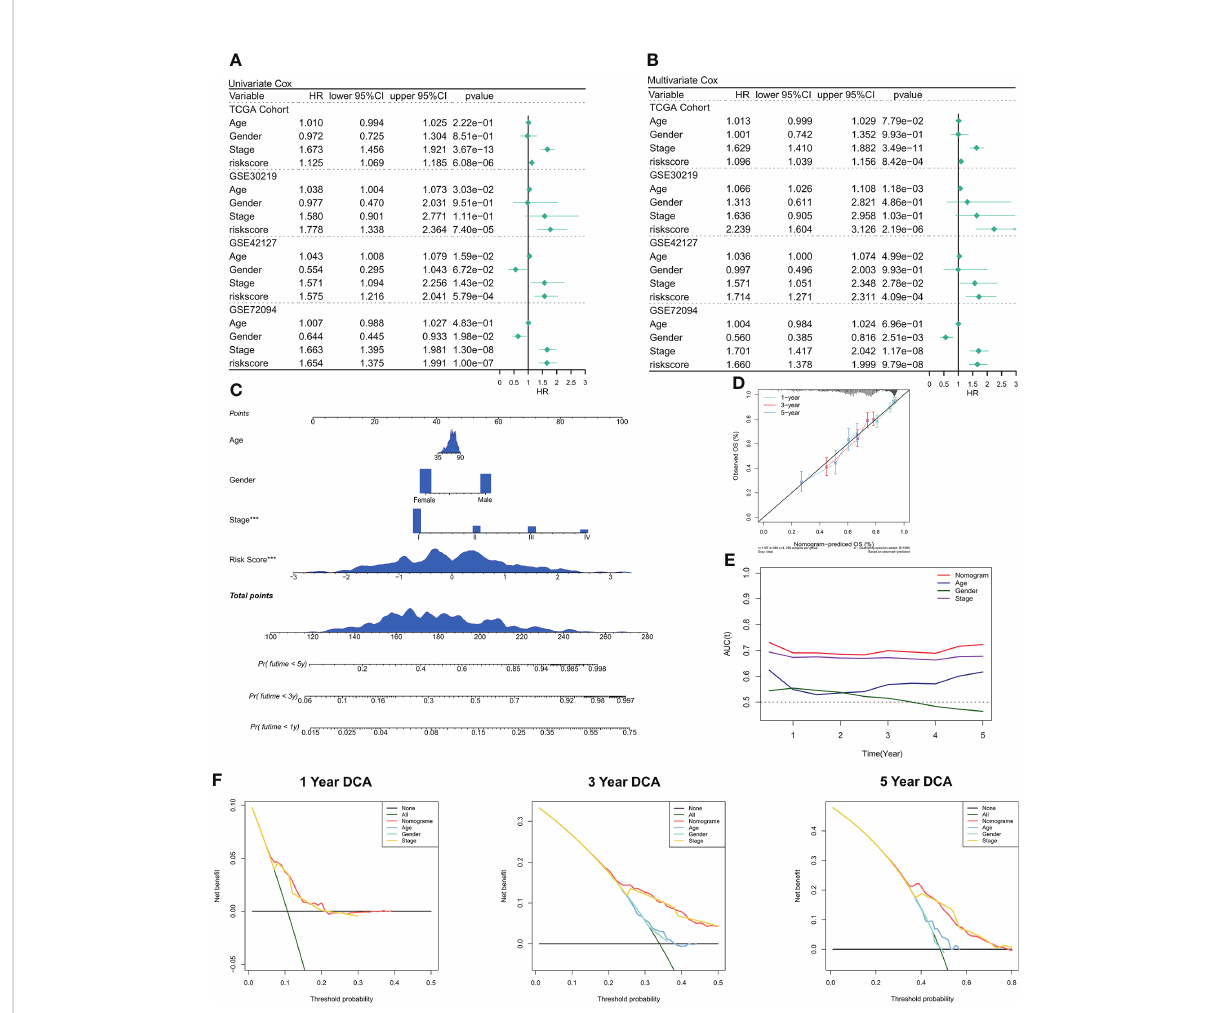
FIGURE 4 Validation of deep learning models related to CRGs. (A) Univariate COX regression of OS in TCGA and GEO datasets. (B) Multivariate COX regression of OS in TCGA and GEO datasets. (C) Nomogram based on deep learning model of CRGs. (D) Calibration curves of Nomogram at 1, 3, and 5 years. (E) Nomogram and tROC curves of clinical characteristics. (F) DCA curves of Nomogram at 1 year, 3 years, and 5